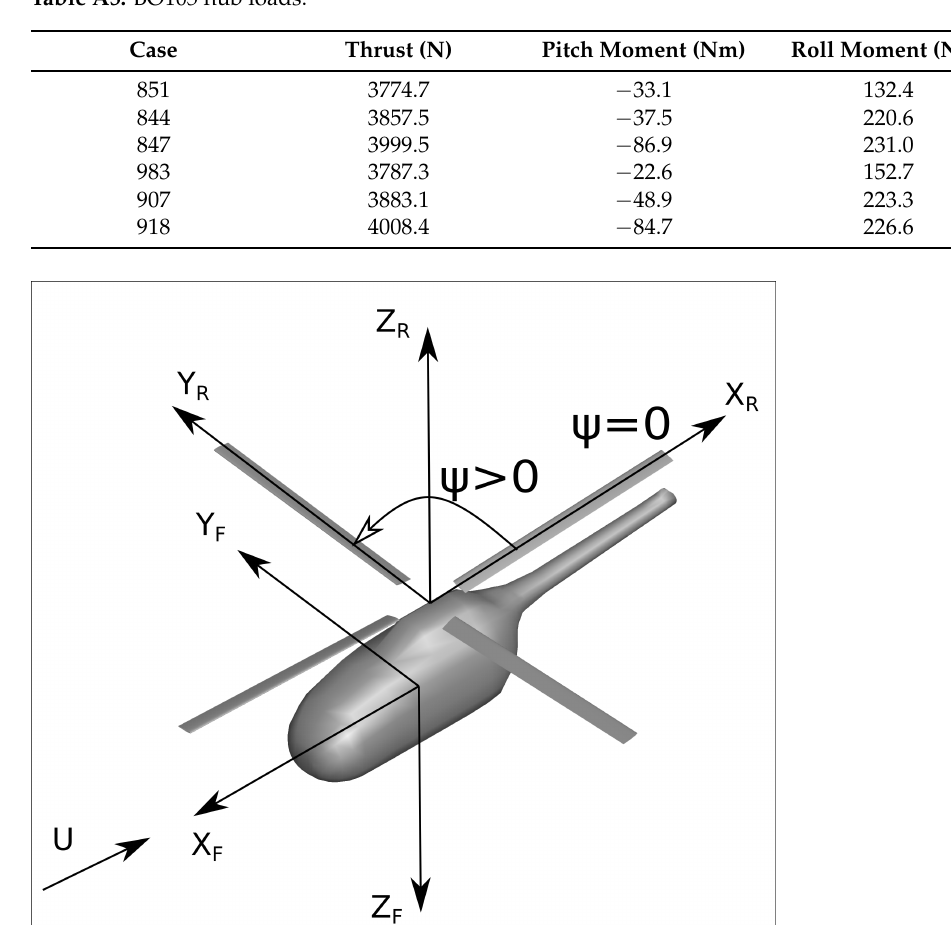
Table A5. BO105 hub loads.